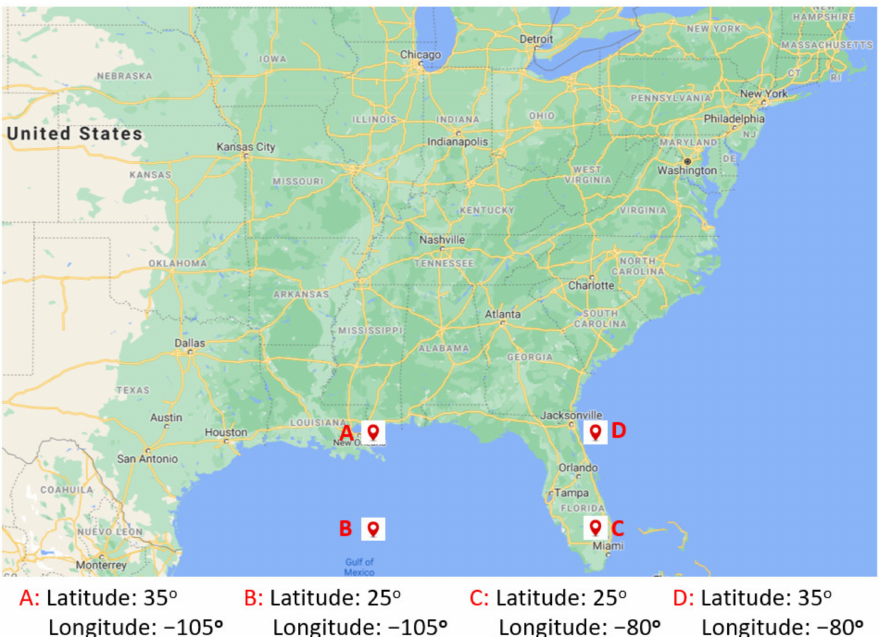
Figure 9. Example of a theater of operations as defined by the rectangle with vertices (A–D).